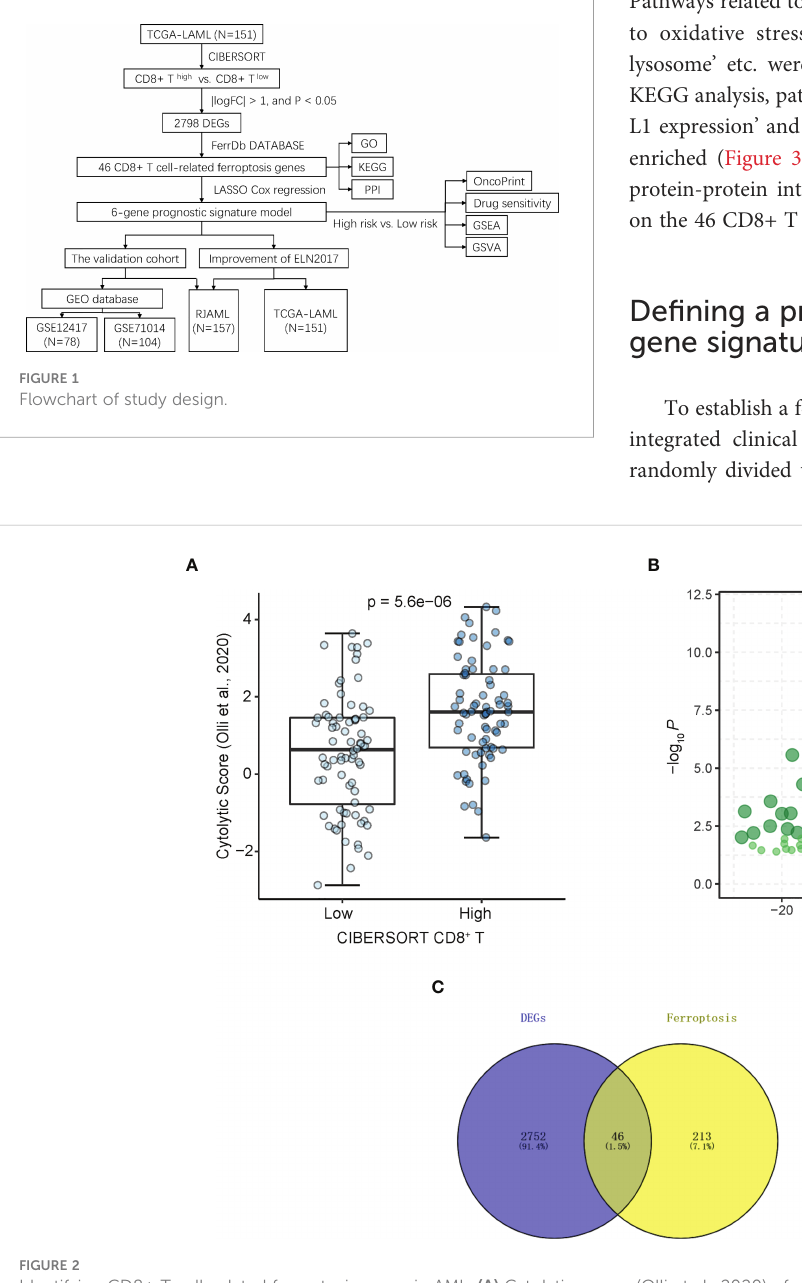
FIGURE 2 Identifying CD8+ T cell-related ferroptosis genes in AML. (A) Cytolytic scores (Olli et al., 2020) of patients from CD8+ T cell high and low groups divided by CIBERSORT. (B) Volcano plot of DEGs. Plots represents differentially expressed genes between CD8+ T cell high and low groups. (C) DEGs associated with ferroptosis.